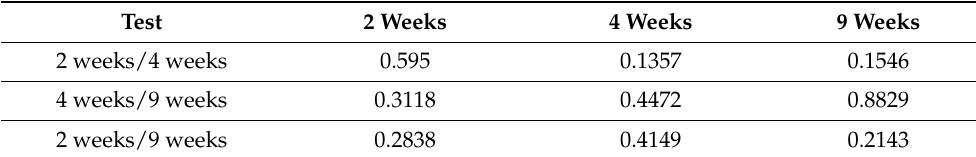
Table 4. Statistical results of the generalized linear mixed model (GLMM) concerning differences in BIC values between the different time